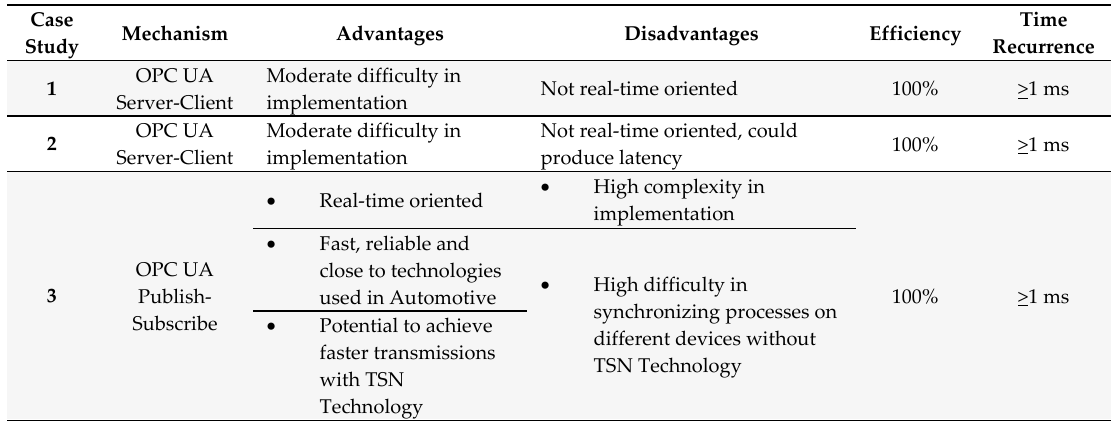
Table 1. Case study results analysis.